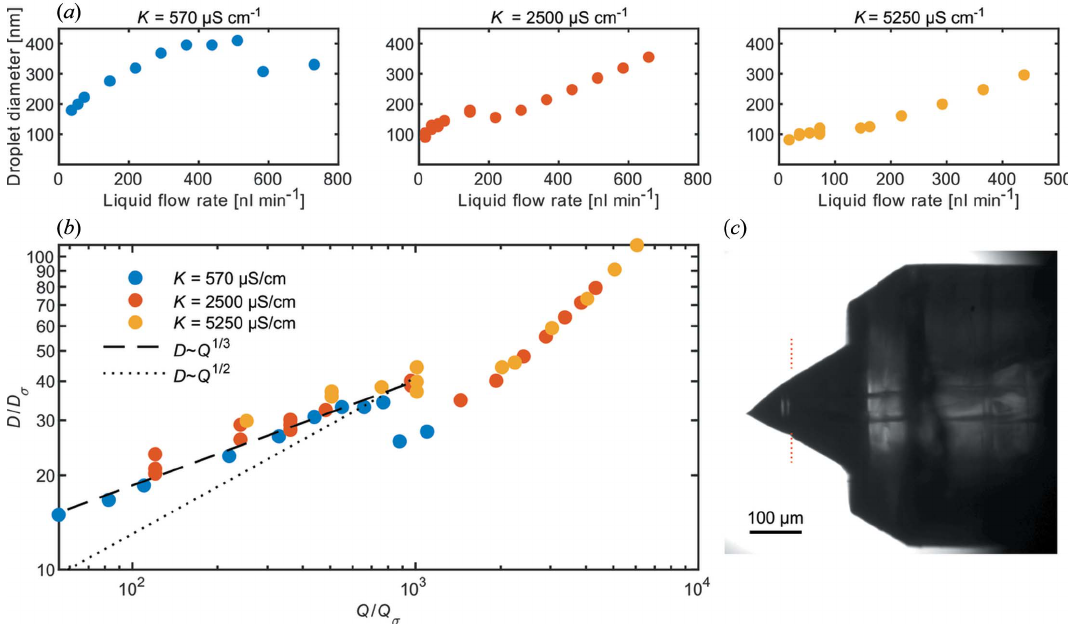
Figure 6 ( a ) Droplet diameters achieved as a function of applied liquid flow rate Q for different conductivities K . ( b ) In the dimensionless parametrization of the flow rate and droplet (Maißer et al. , 2013), the droplet diameters from the different conductivities fall on the same curve. ( c ) A side-view microscopy image (0.92 m m pixel size) of the 2PP-3D printed CCT. The 40 m m ID of the electrospray tip exactly matches the ID of the utilized fused silica capillary and the 30 (cid:8) angle at the tip is seamlessly transferred to the angle of the formed liquid cone. The tip–liquid interface is indicated with the dotted red